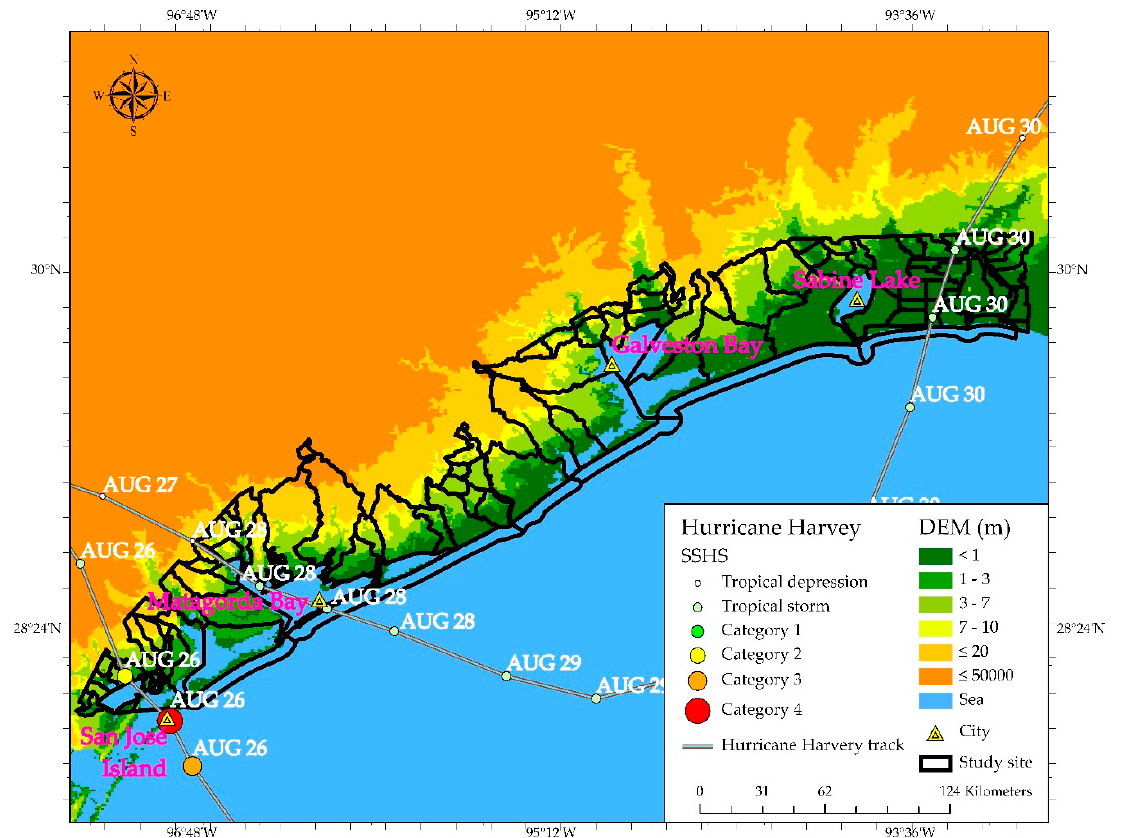
Figure 2. Hurricane Harvey’s movement within the study area. SSHS represents Saffir–Simpson hurricane wind scales introduced by Taylor et al. [59]. The study area (black polygon) consists of a series of hydrological units, at sub-watershed level, used to estimate flood extents. The curved cyan line represents the best tracking path of the hurricane and the proportional dot symbols with labels indicate the specific hurricane intensity across the time it was present on the Texas coast.